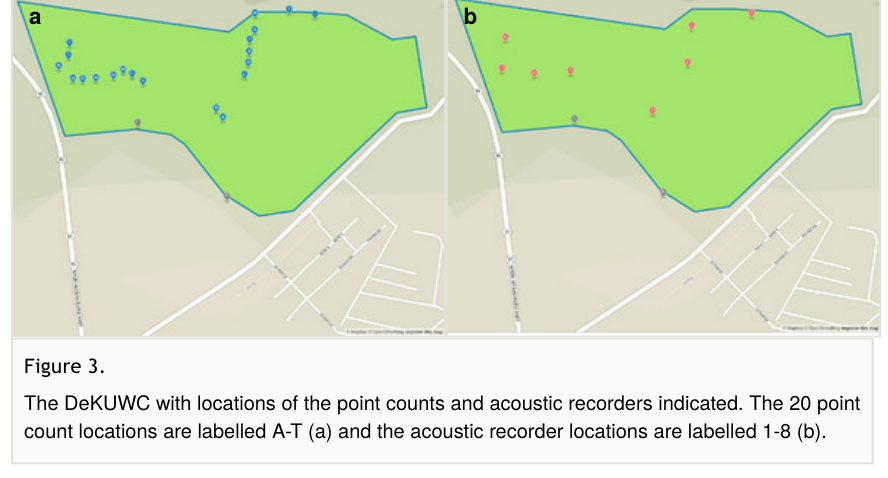
Figure 3. The DeKUWC with locations of the point counts and acoustic recorders indicated. The 20